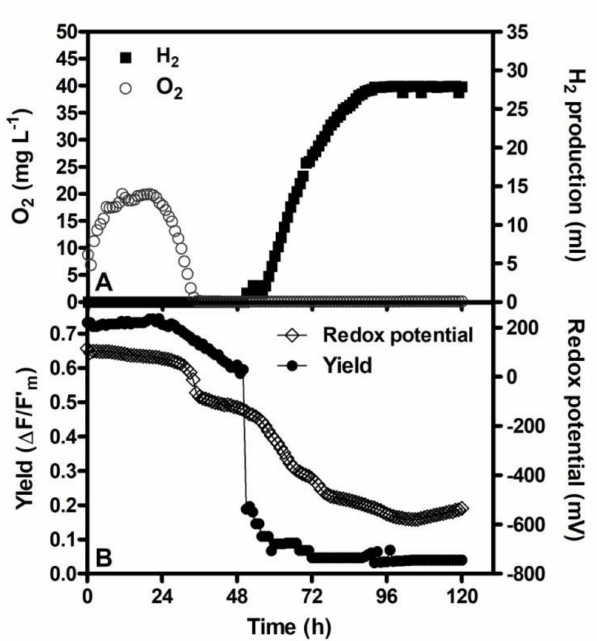
Figure 5. C. reinhardtii kinetics of chlorophyll fluorescence and redox potential during induction of H 2 production under sulfur deprivation. ( A ) Time courses in dissolved oxygen (empty circle) and output of hydrogen (H 2 ) (filled square). ( B ) The time courses in the effective quantum yield of PSII ( ∆ F/F (cid:48) m ) (filled circle) and the redox potential (Eh) (empty diamond) in C. reinhardtii under sulfur deprivation with 70 µ mol photons/m 2 /s, supplied on both sides of the reactor.